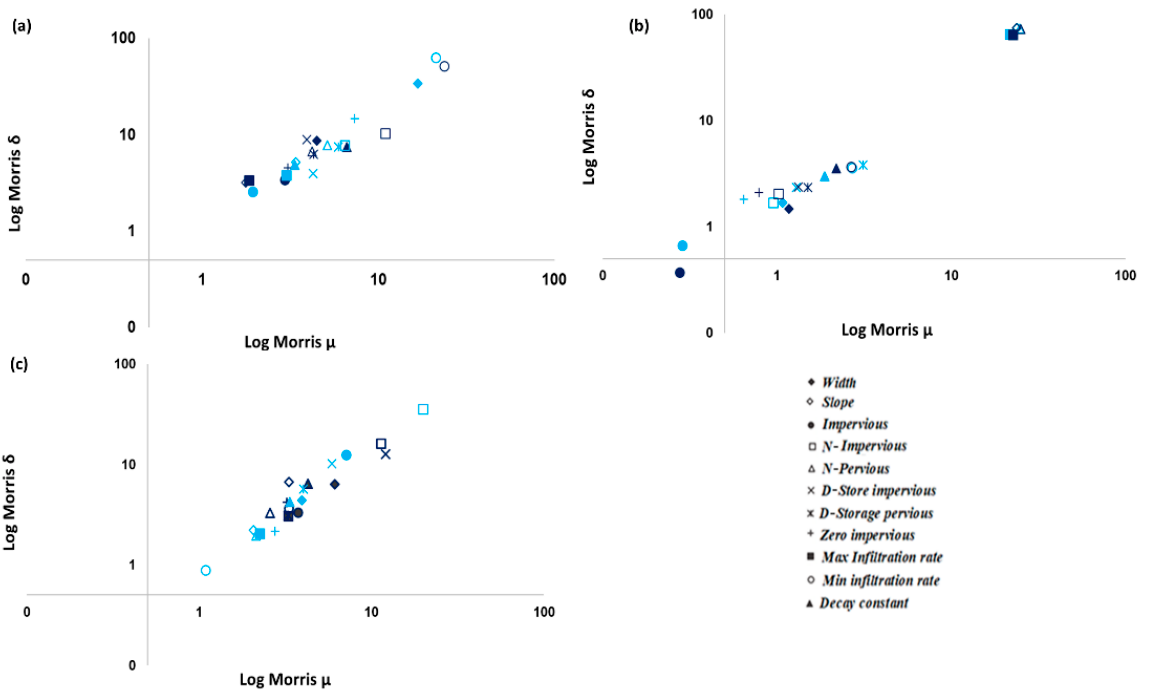
Figure 7. Morris sensitivity analysis for ( a ) total runoff, ( b ) infiltration, and ( c ) and evaporation where dark blue shows sensitivity of noted parameter for SWMM-LITE and light blue for SWMM.